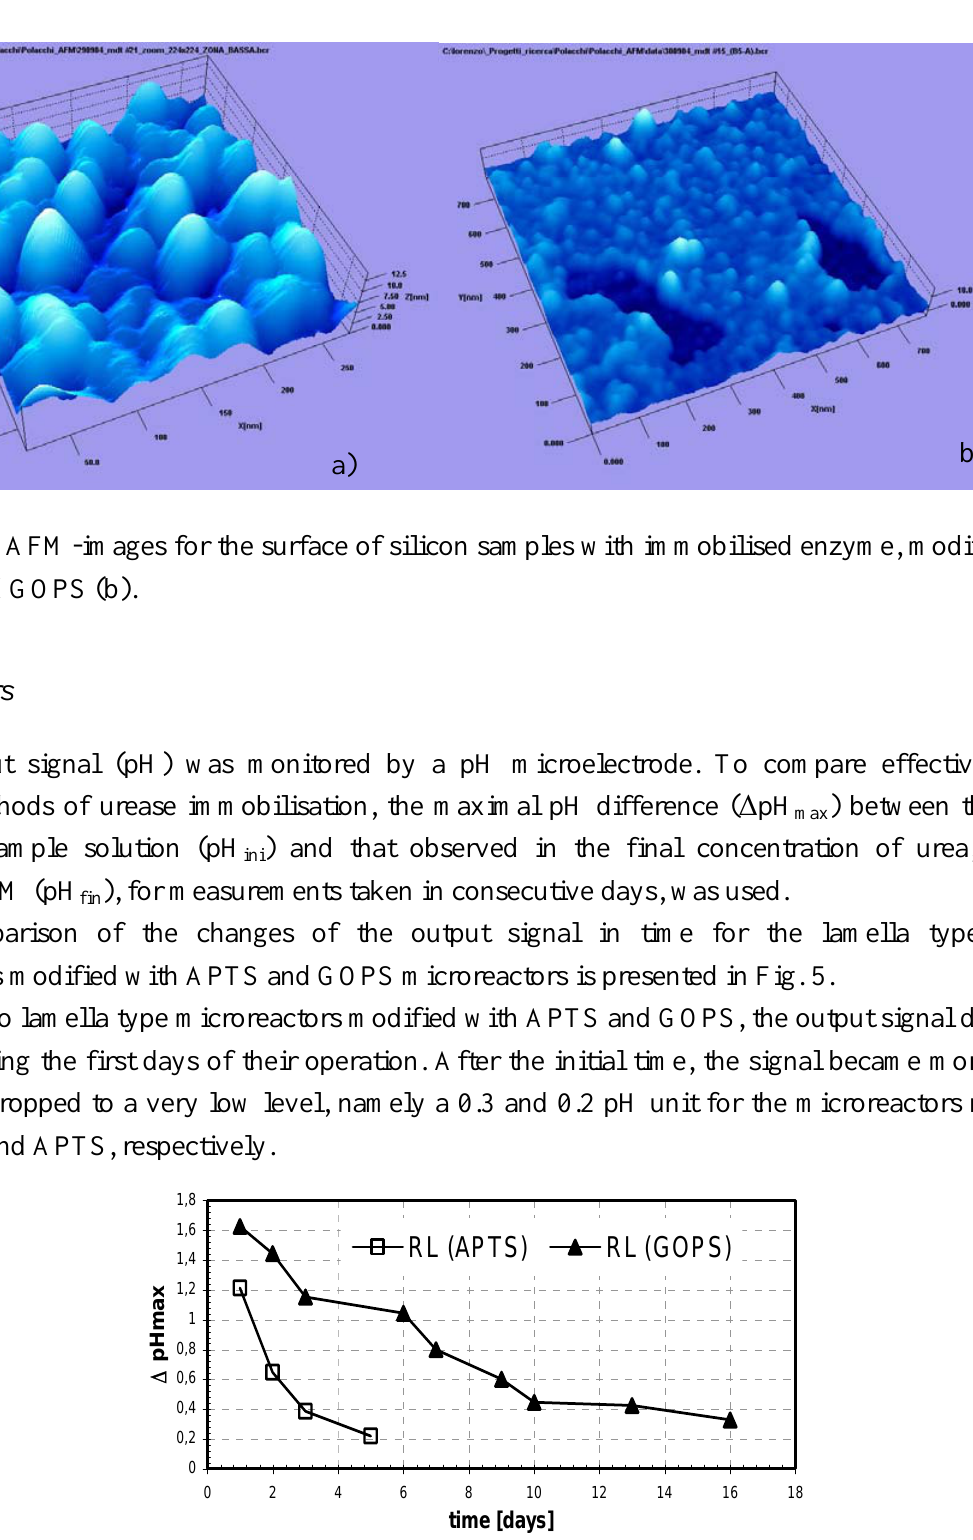
Figure 5. Changes of the output signal (pH modified with GOPS and